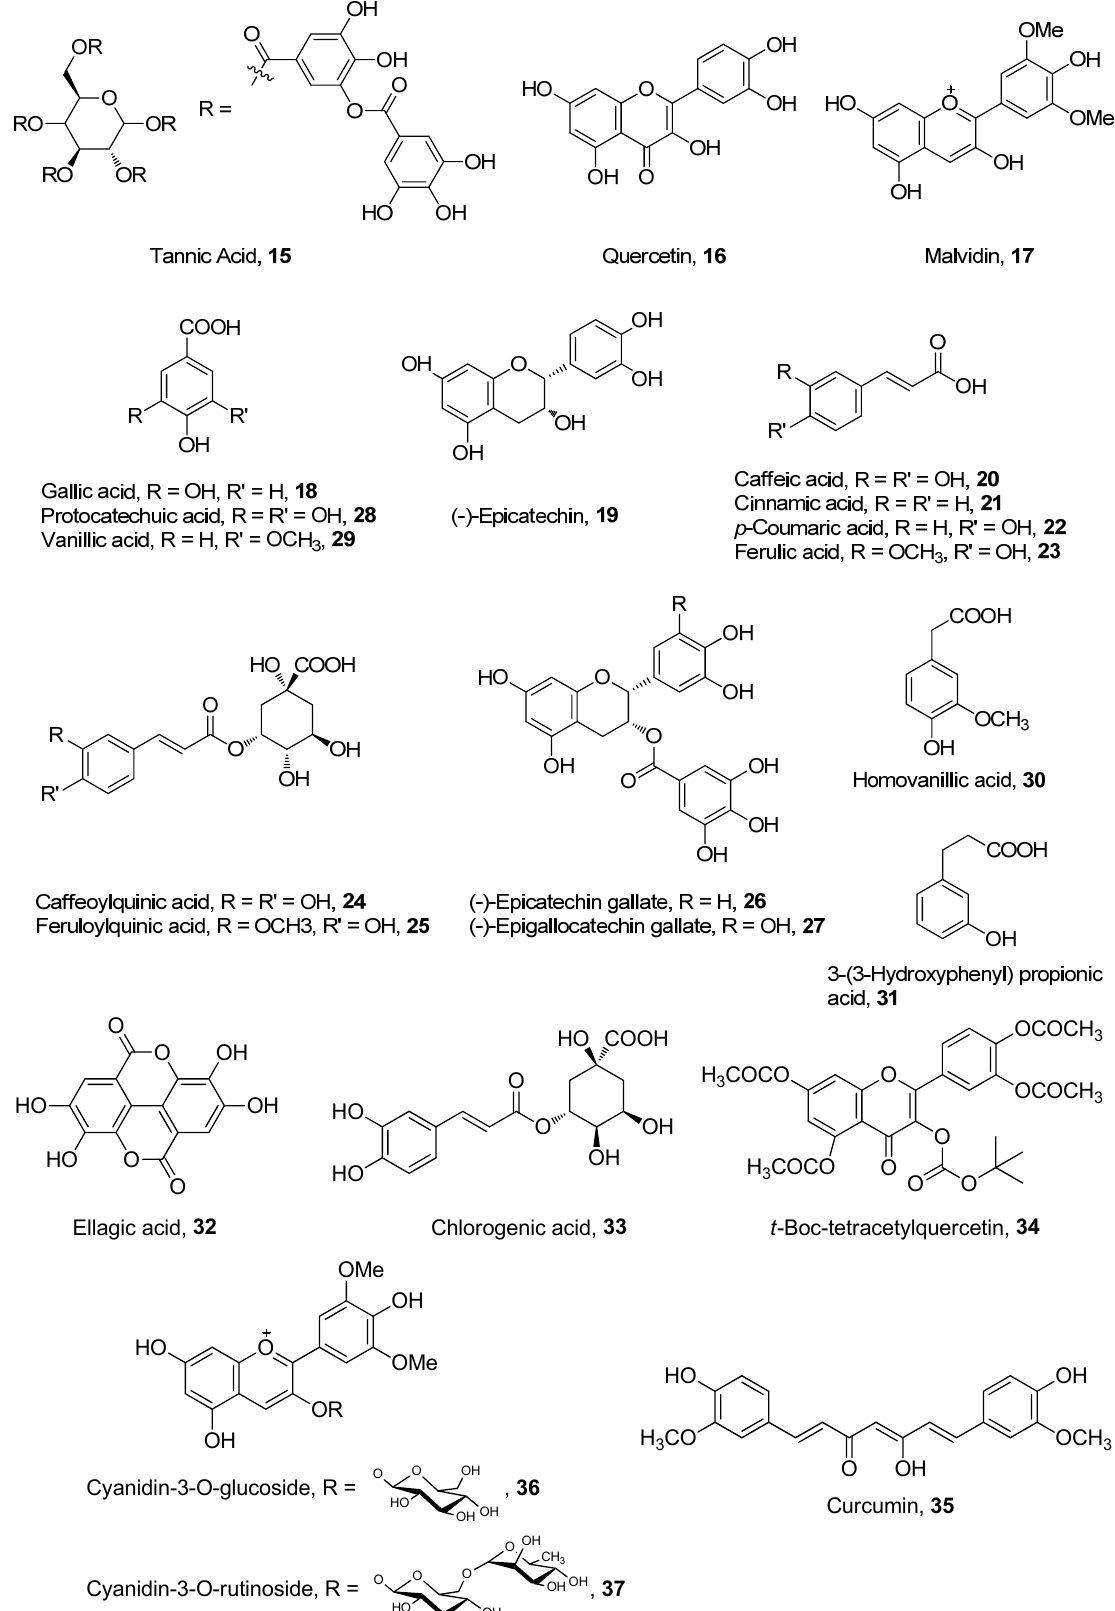
Figure 5. Polyphenolic compounds with recently investigated oral